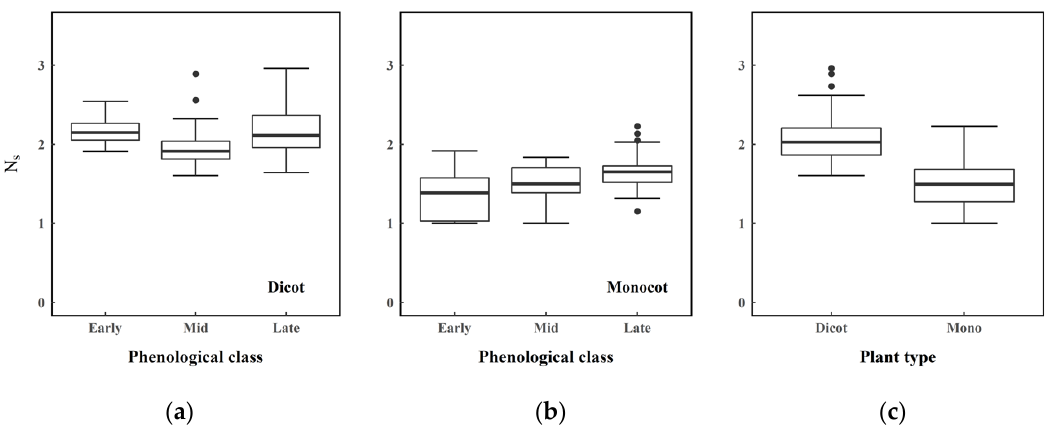
Figure 6. Box plots of the distribution of N s as a function of plant type and phenological class: ( a )